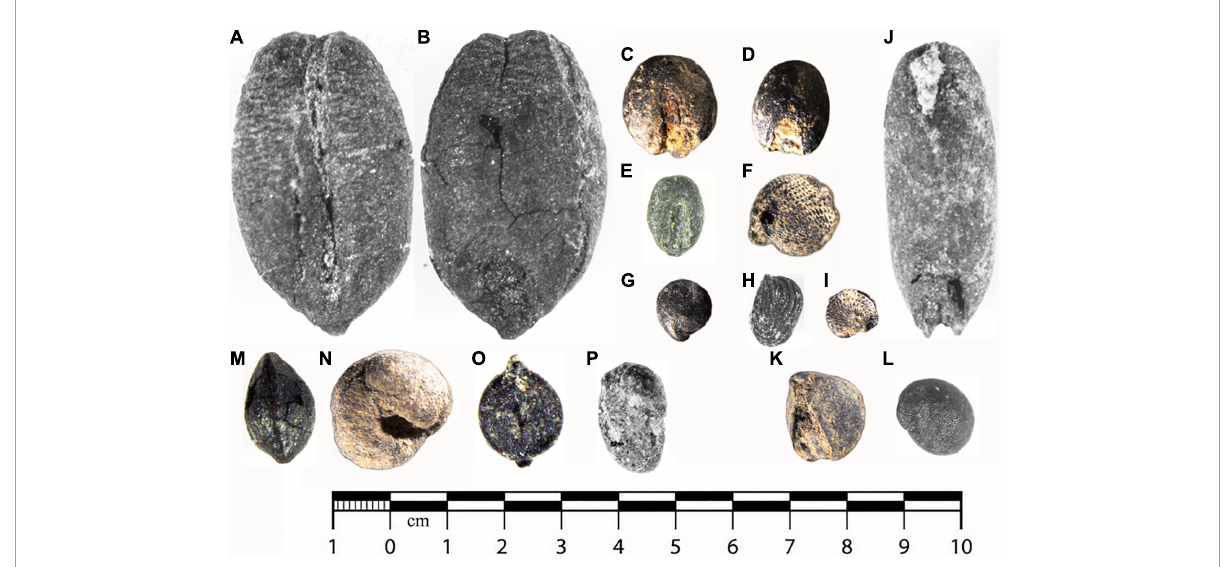
FIGURE2 Charred grains recovered from excavated eastern Tianshan complexity (ETC) sites. (A) Hordeum vulgare (ventral side) and (B) Hordeum vulgare (dorsal side) from barley cache at Shirenzigou IV F7; (C) Setaria italica from Shirenzigou III F1; (D) Panicum miliaceum from Shirenzigou III F1; (E) Setaria viridis from Shirenzigou III F1; (F) Lepyrodiclis holosteoides from Shirenzigou III F1; (G) Chenopodium album from Shirenzigou III F1; (H) Thlaspi arvense from Shirenzigou III F4; (I) Silene conoidea from Shirenzigou III F1; (J) Avena fatua from Haiziyan; (K) Convolvulus sp. from